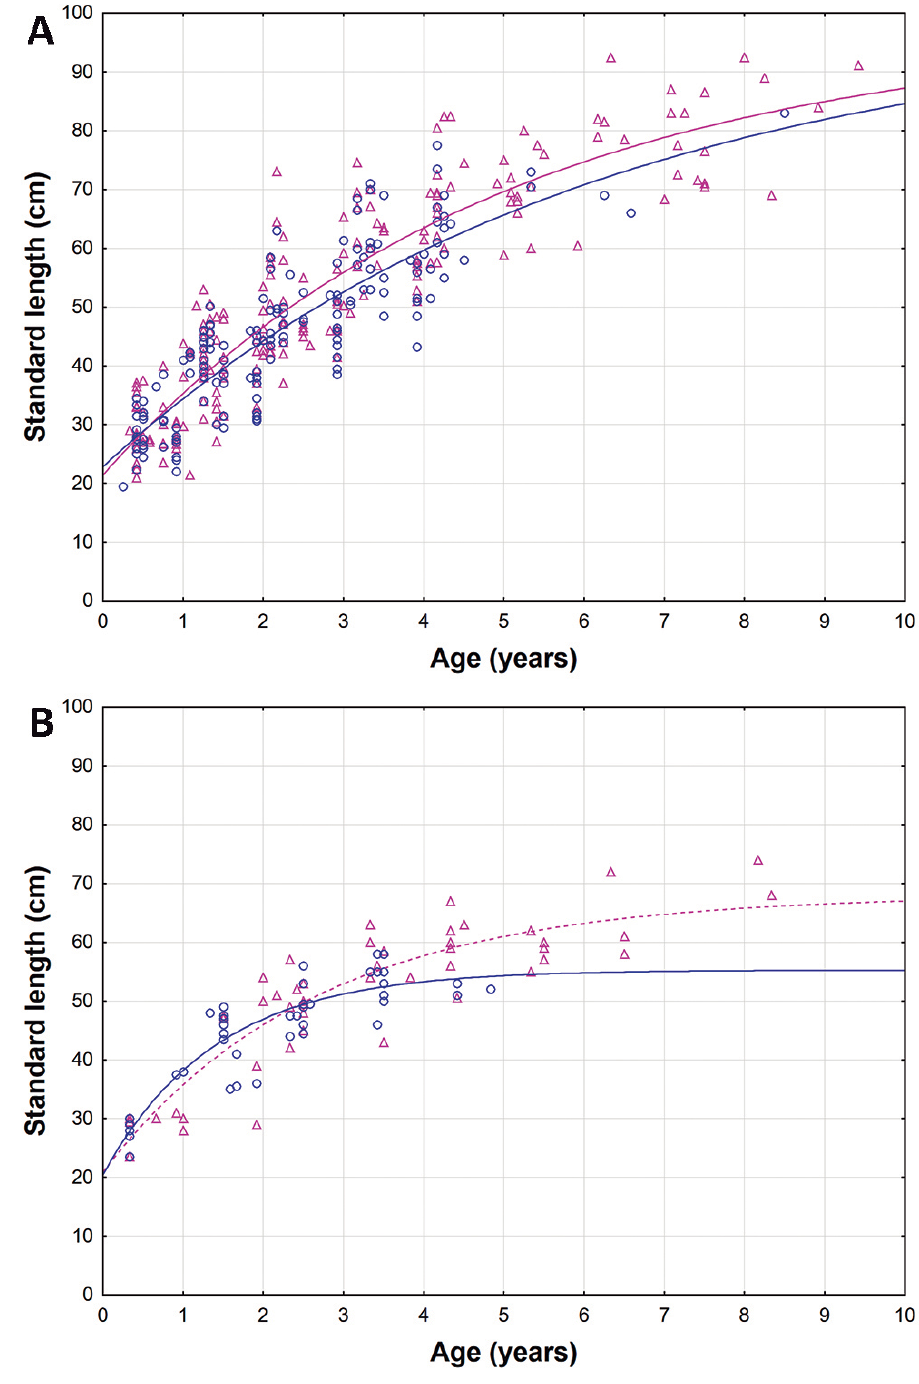
FIGURE 6 | Von Bertalanffy growth curves for Pseudoplatystoma punctifer females (pink triangles) and males (blue circles) in the A . AMU system and B . Putumayo